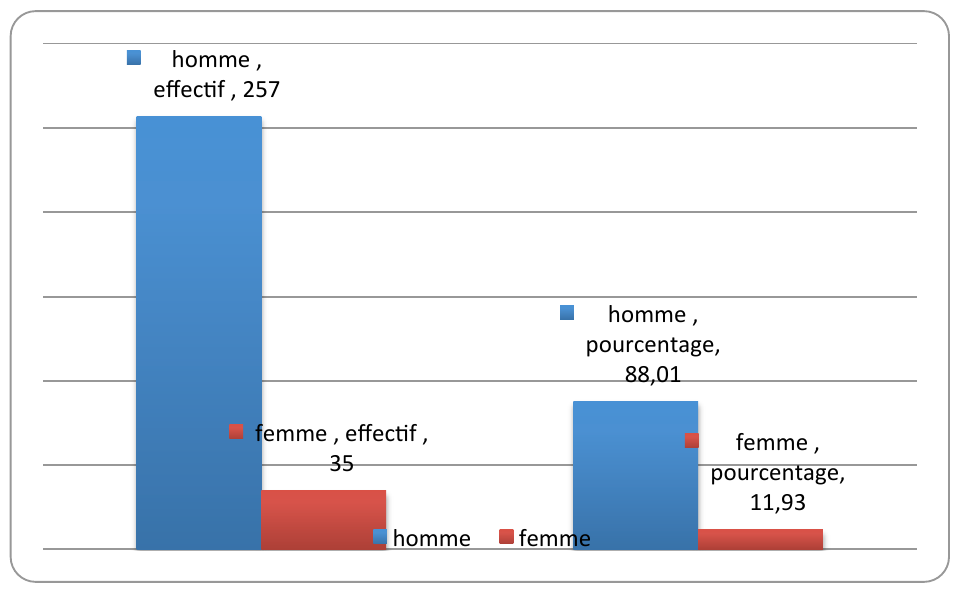
Figure 3. Sexe des